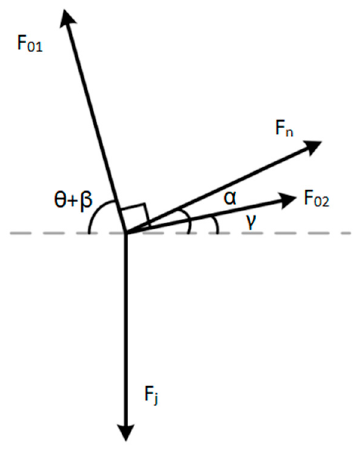
Figure 6. Force on lever.